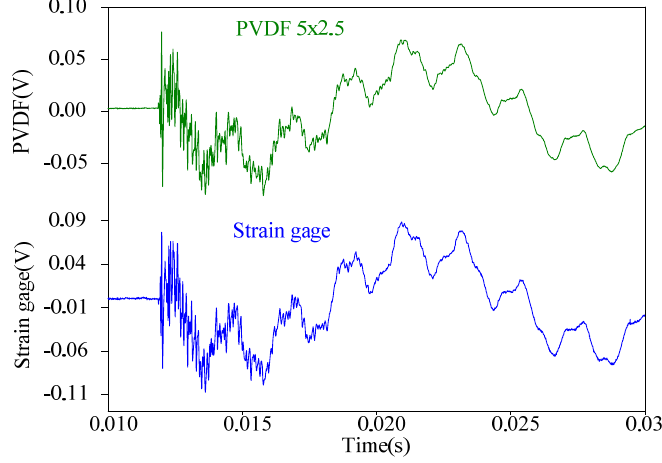
Figure 12. Measurement results of PVDF 5 × 2.5 and the strain guage with impact on location A.